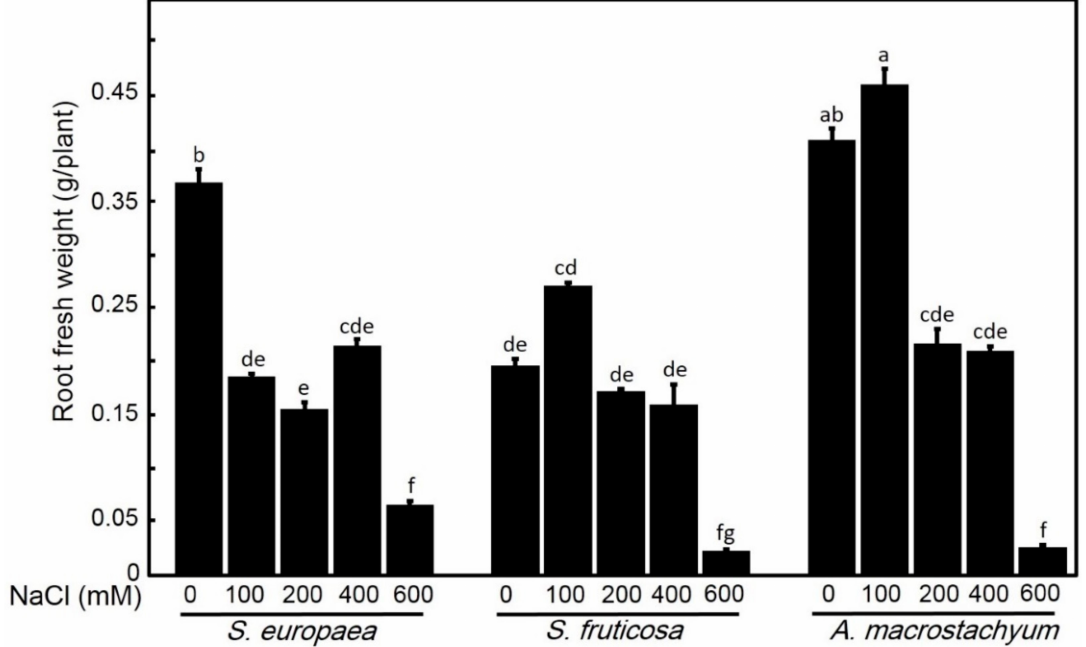
Figure 2. Root fresh weights of S. europaea, S. fruticosa and A. macrostachyum under different NaCl concentrations. Mean ± SE of three replicates. Different letters indicate significant differences ( p <